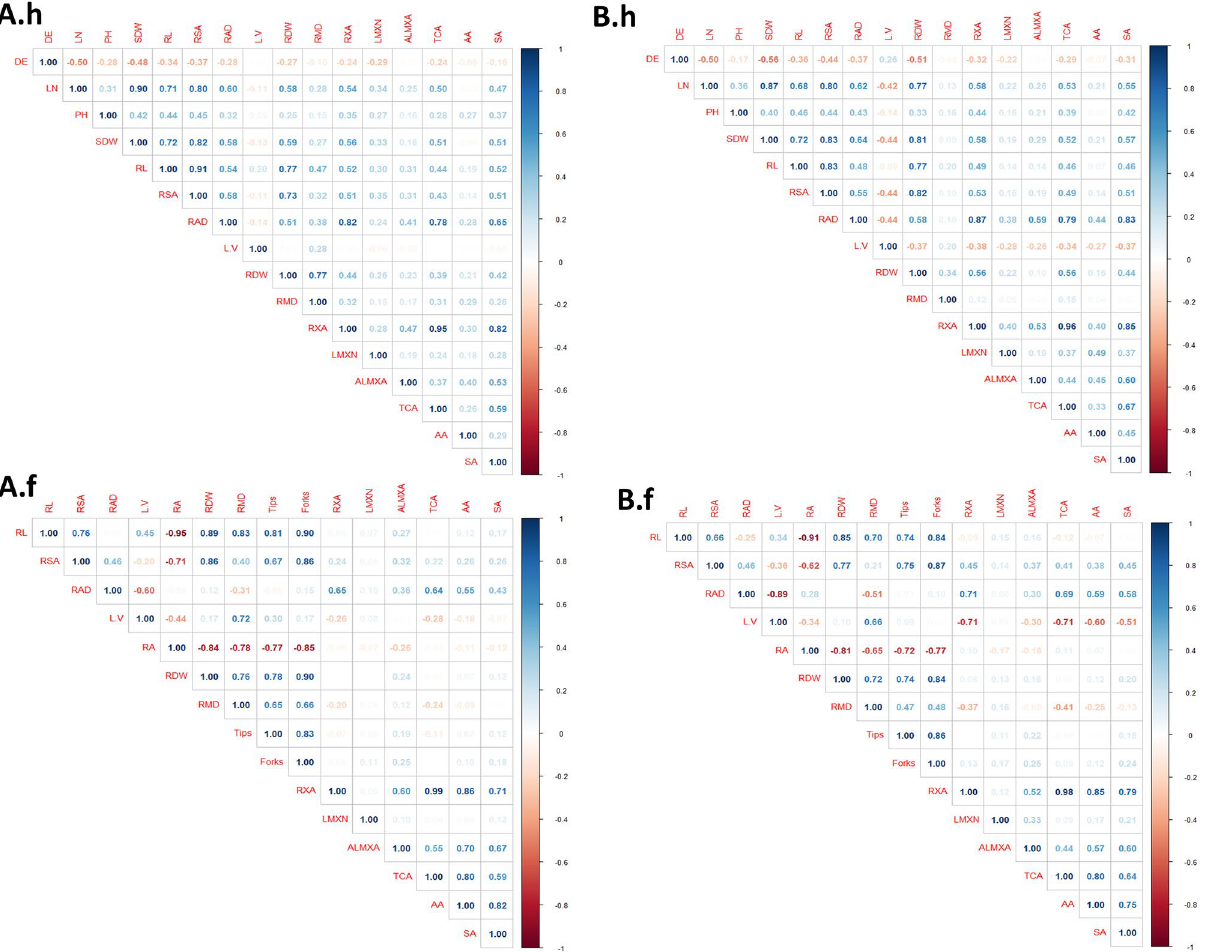
Figure 4. Correlation matrix for shoot morphological (only in hydroponic conditions; A.h and B.h ), root architectural and anatomical traits in two groups of barley populations and their parental lines grown across two growing conditions. ( A )—conventional and ( B )—organic cropping systems. ( A.h )—conventional under hydroponic, ( B.h )—organic under hydroponic, ( A.f )—conventional under field, and B.f—organic under field conditions. The color scale represents Spearman’s ranked correlation coefficient. A larger circle size indicates a smaller p -value; blank cells represent that correlation was non-significant at P < 0.05. Most strongly associated traits are ordered and grouped in black boxes based on hierarchical clustering. See Table 1 for trait